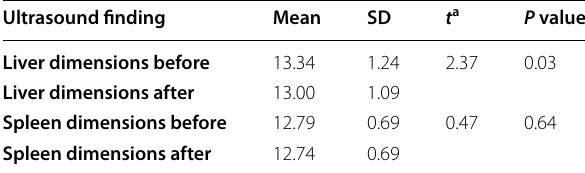
a Paired samples t test Table 6 Pelvic–abdominal ultrasound examination before and after SVR at 12 weeks among patients in group D Ultrasound